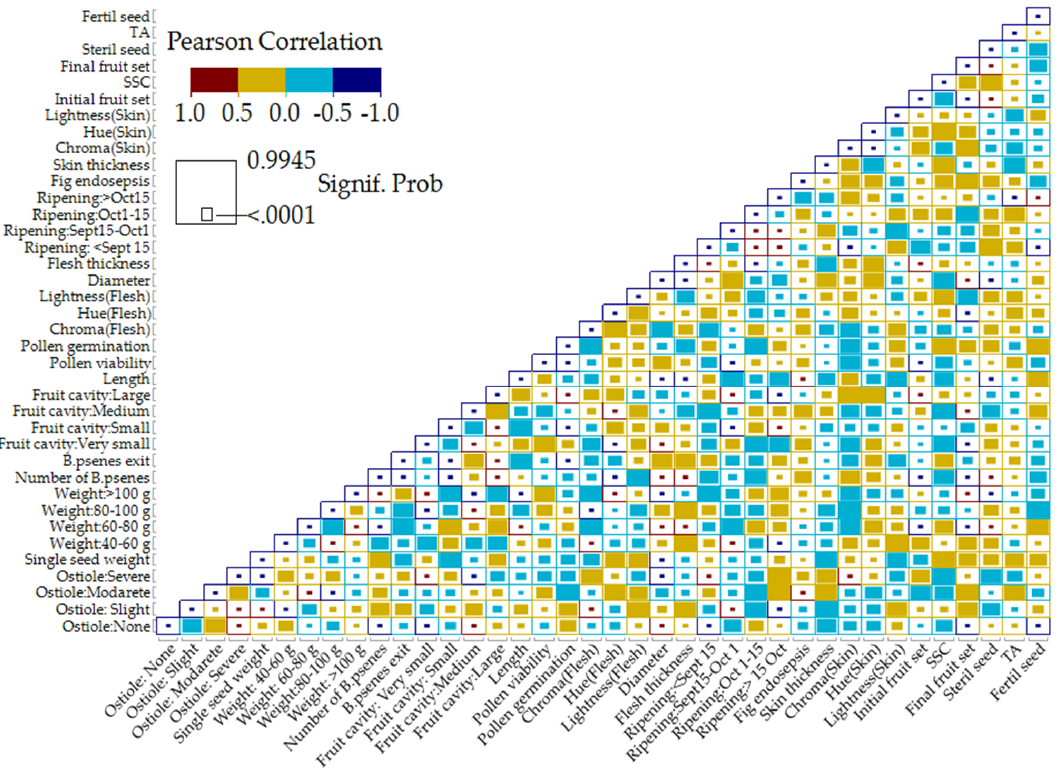
Figure 5. Heat map showing Pearson’s correlation coefficients for all traits. Self-self correlations are identified in dark blue. Color indicates the direction (positive/negative) and the strength of the correlation, while the size of the circle represents the significance value.